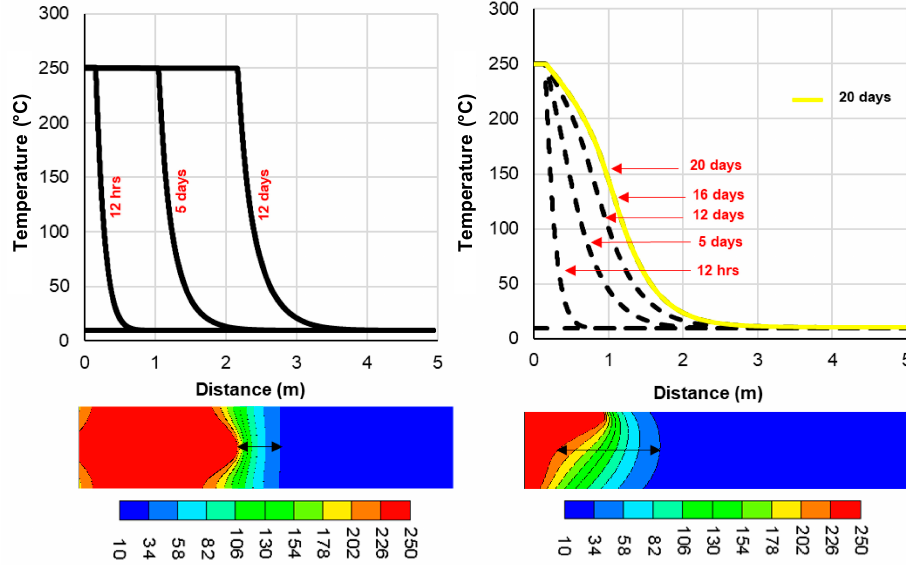
Figure 4. Temperature versus distance at different times for the Vertical Elemental (VE) ( left ) and the Horizontal Elemental (HE) ( right ) models. 2D images of the temperature profile at 12 and 16 days of steam injection are displayed underneath. Notice that for the HE model, at 20 days, temperature profile overlaps profile at 16 days. The VE model has been rotated by 90 degrees to the right.